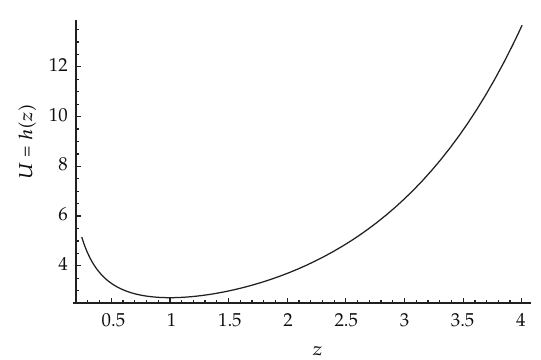
Figure 1: Map of z (cid:6) − x 1 / ln y